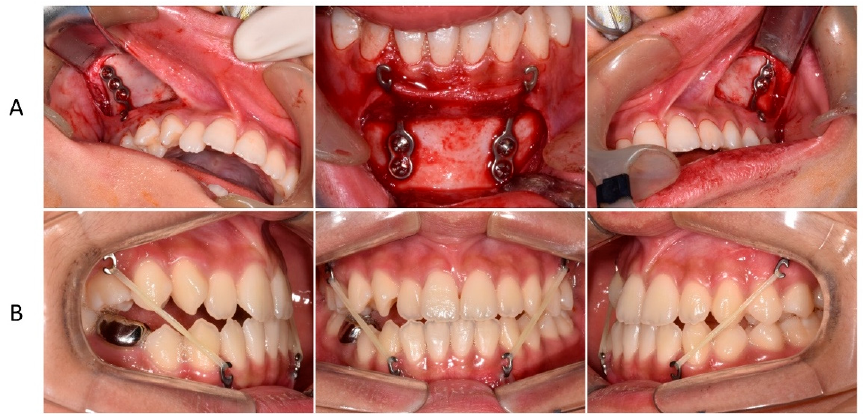
Figure 3. Insertion and use of the miniplate: ( A ) surgery for miniplate insertion; ( B ) use of Class III inter-maxillary elastics.